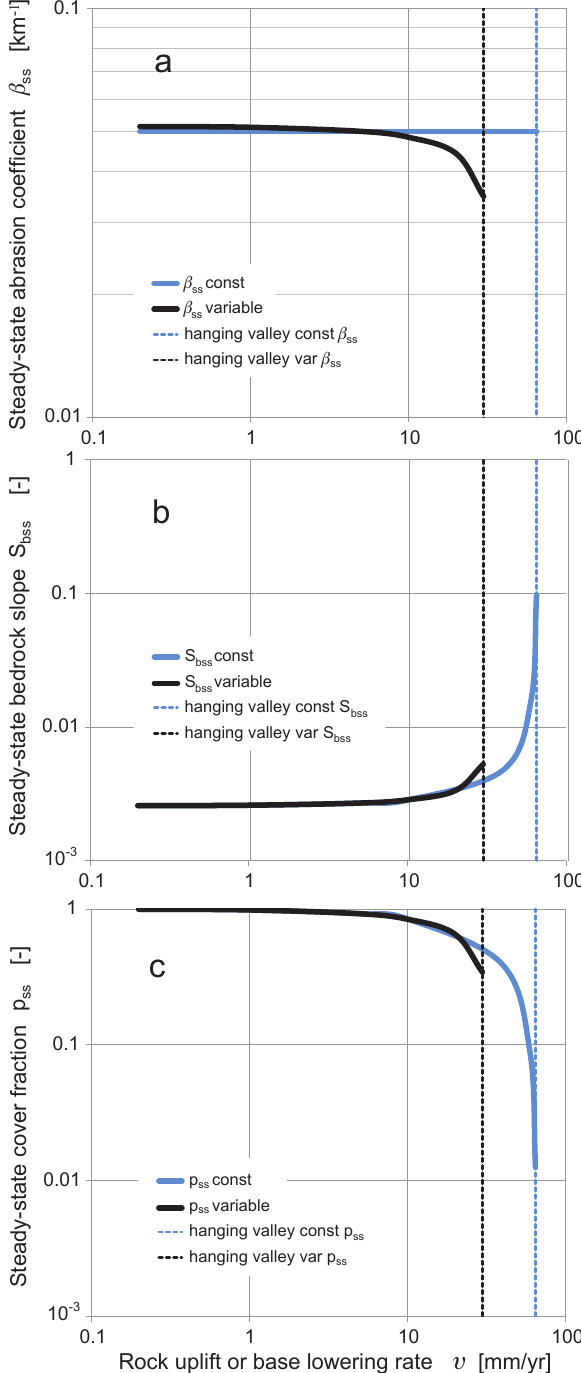
Figure 9. Variation at steady state (black curves) of (a) abrasion coefficient β ss , (b) bedrock slope S bss and (c) cover fraction p ss and parameter ϕ on rock uplift or base lowering rate υ , for a high bedload feed rate of 3.5 × 10 5 tyr − 1 . The cases of constant, spec- ified β ss and S bss varying according to Eq. (34) are shown as blue curves. The vertical dashed lines denote the incipient conditions for the formation of a hanging valley. The predictions are the same for the CSA and MRSAA